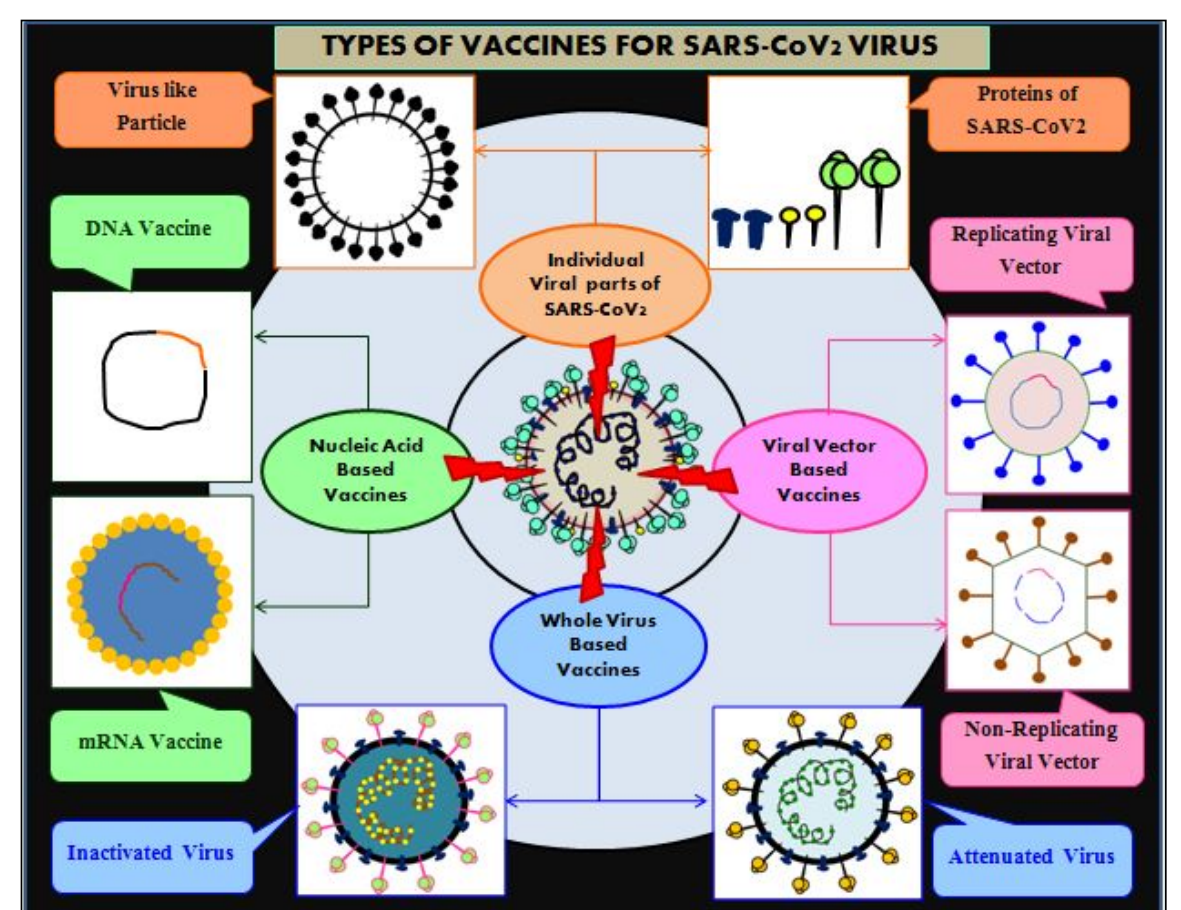
Figure 9. Various types of vaccine platforms used to mitigate COVID-19 pandemic. Major types of vaccine platforms: viral vector vaccines of non-replicating andreplicating types; nucleic acid vac- cines based on DNA and mRNA; vaccines based on recombinant proteins/subunit/VLPs virus-like particle;vaccines based on virus-based on inactivated and live attenuated viral components.